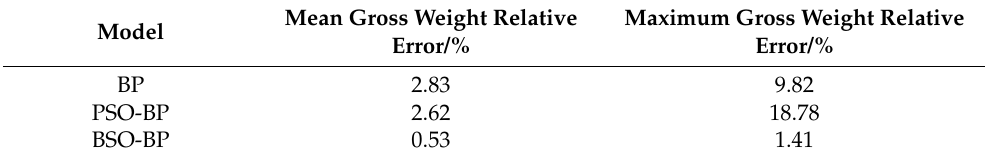
Table 2. Mean gross weight relative error and maximum gross weight relative error for the three models.